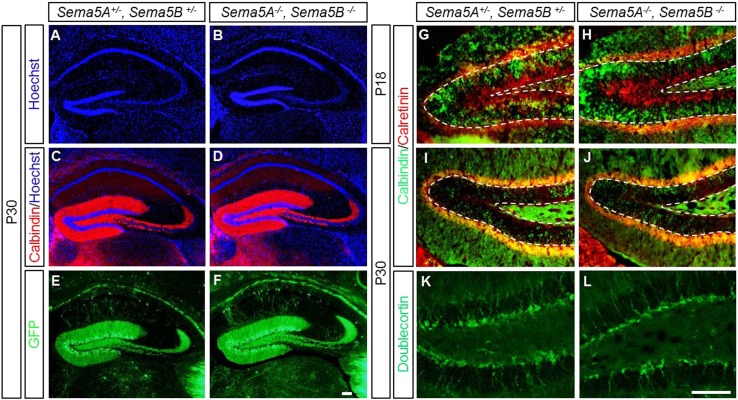
Normal maturation and patterning of dentate GCs in Sema5A−/−
; Sema5B−/− double mutants.(A and B) Coronal sections of age-matched (P30) double-heterozygous and double-mutant Sema5A, Sema5B brains at the level of the rostral hippocampus. Tissue sections were stained with the nuclear dye Hoechst 33,342 to assess gross morphology of the dentate gyrus and the CA1 and CA3 pyramidal cell layers. (C and D) At P30, anti-calbindin immunolabeling revealed no obvious differences in GC axonal and dendritic processes between Sema5A+/−; Sema5B+/− and Sema5A−/−; Sema5B−/− mice. n = 3 mice per genotype. (E–F) Sema5 mice were intercrossed with the Thy1-GFPm reporter mouse. Consistent with anti-calbindin labeling, no obvious defects in GC dendritic protrusions, axonal targeting or pruning to the CA3 subfield was observed. n = 3–4 mice per genotype. (G–J) Double immunofluorescence labeling of calbindin (green), a marker for mature GCs, and calretinin (red), a marker for immature GCs. (G and H) Coronal sections of P18 DG and (I and J) P30 DG showed no differences in labeling between Sema5A+/−; Sema5B+/− and Sema5A−/−; Sema5B−/− mice. Dashed lines demarcate the inner and outer borders of the dentate granule cell layer. (K and L) P30 DG coronal section of Sema5A+/−; Sema5B+/− and Sema5A−/−; Sema5B−/− mice immunostained for doublecortin (DCX), a microtubule-associated protein expressed in immature GCs during migration. No differences in abundance or distribution of DCX positive cells were observed between the different genotypes. n = 3 mice per genotype. Scale bars = 100 µm (A–F) and for (G–L).